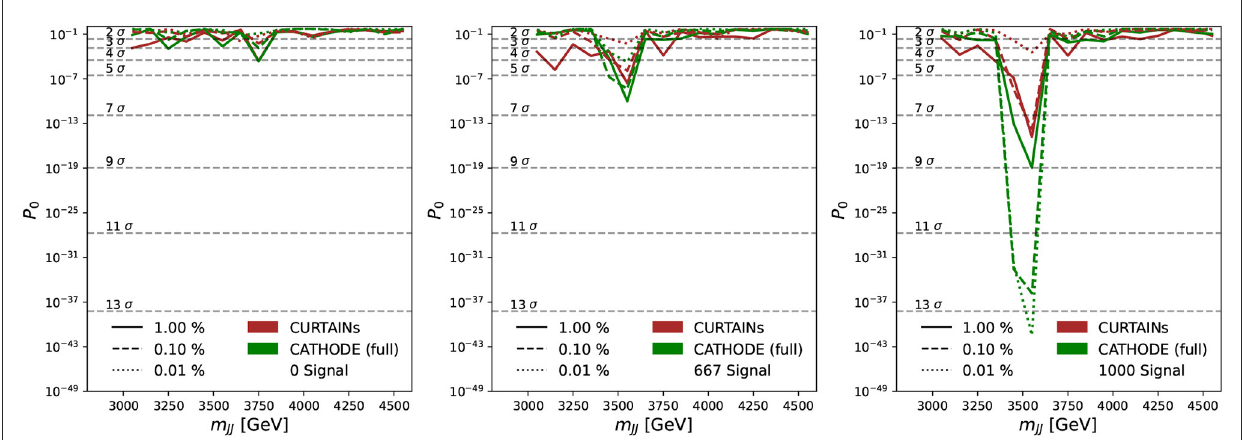
FIGURE11 Measured excesses in each of the signal regions probed in the sliding window, from 3,300 to 4,600 GeV, for the case of samples doped with 0 (left) , 667 (middle) , and 1,000 (right) signal events. Each signal region is 200 GeV wide and split into two 100 GeV wide bins. The solid, dashed, and dotted lines show the probability of the observed excesses ( p 0 ) over the background after applying a cut on classifier trained using the background predictions from the C URTAIN s (red) and C ATHODE (full) (green) methods at 1, 0.1, and 0.01%, respectively. The cut values are calculated per signal region using the background